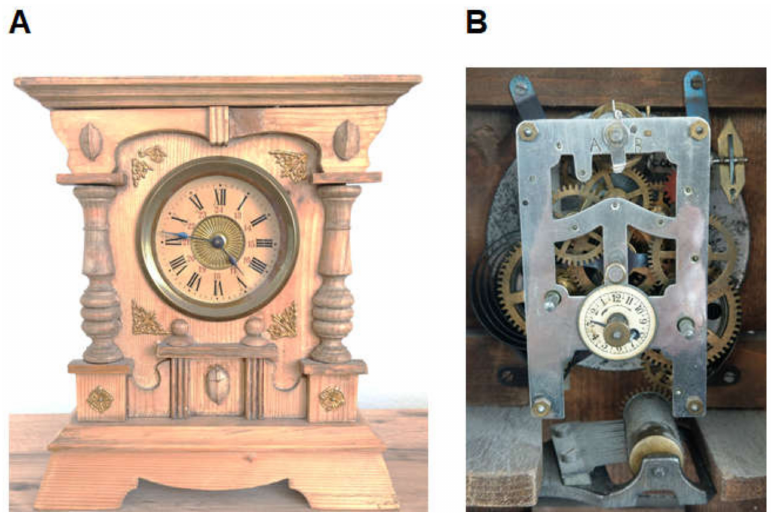
Figure 1. A clock from 1890. ( A ) Front view and ( B ) the intricate inner workings of the gears of a mechanical clock combined with a musical